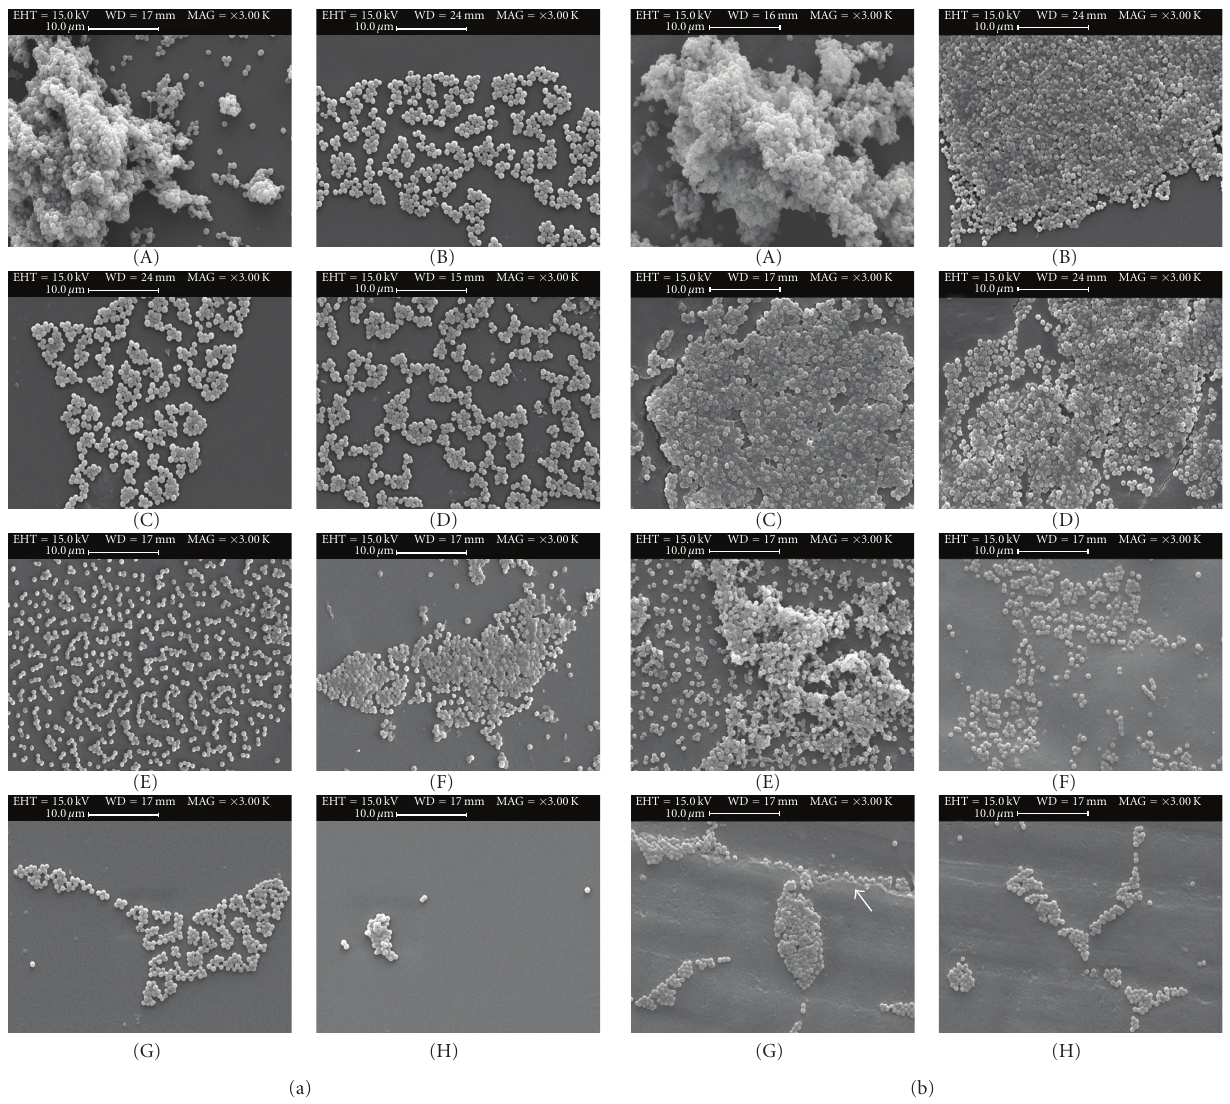
Figure 2: SEM photomicrographs of S. epidermidis adhered to acrylic (a) and silicone (b) surfaces. Strains: A—IE214; B—IE186; C—9142; D—9142-M10; E—1457; F—1457-M10; G—IE75; H—LE7. The arrow shows bacterial cells adhered along a depression on silicone’s surface. Magnification × 3000, bar = 10 μ